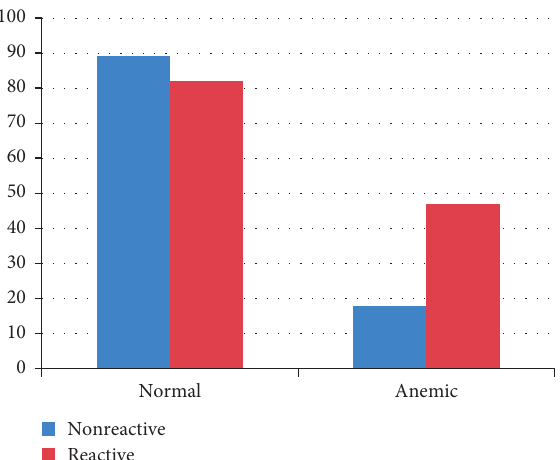
Figure 3: Anemia and HP infection among the study participants in Kulito Health Center, SNNPR, Ethiopia, 2018 ( n � 236).